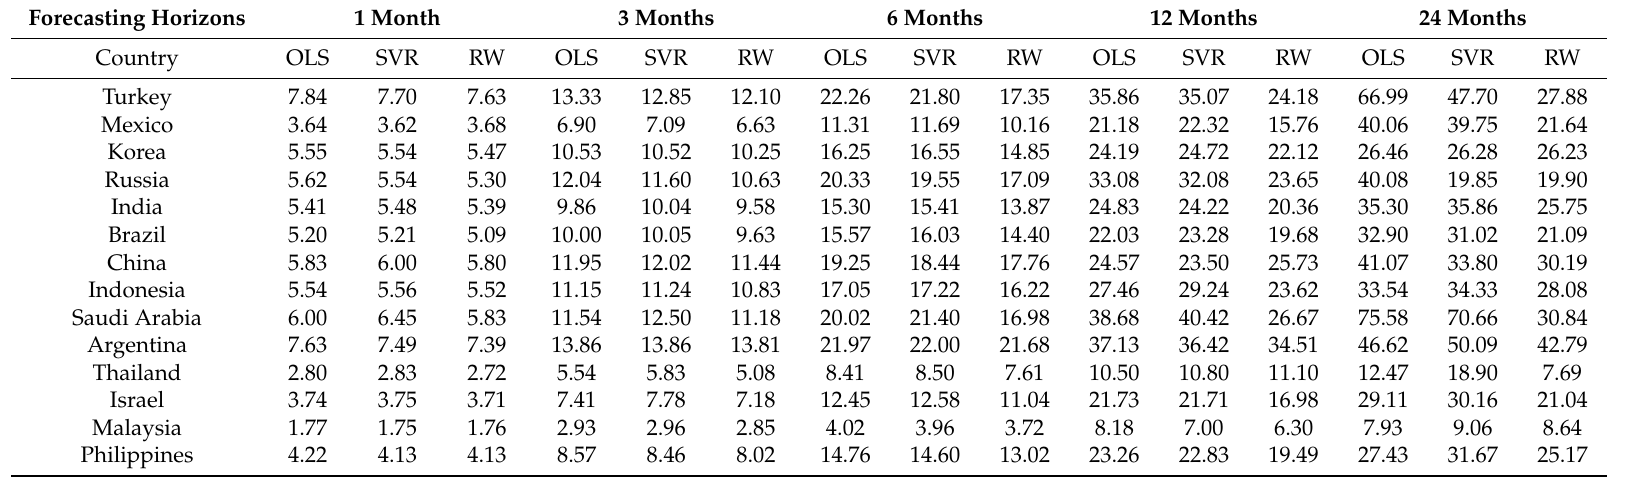
Table 4. Stock Indices out-of-sample forecasting